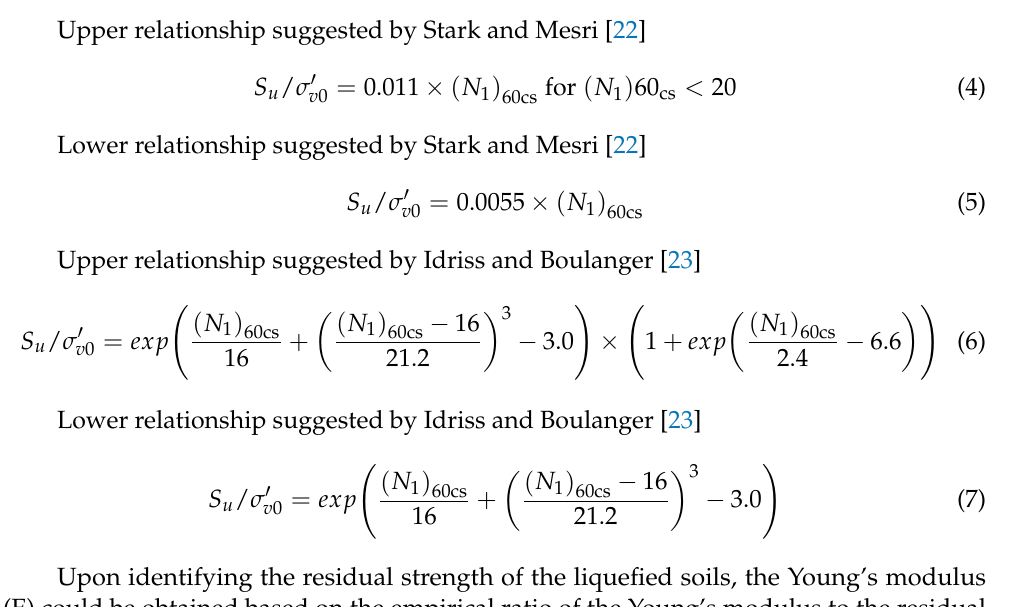
Figure 8. The relationship between normalized undrained residual shear strength S u / σ (cid:48) v 0 and clean sand equivalence of corrected SPT blow count (( N 1 ) 60cs